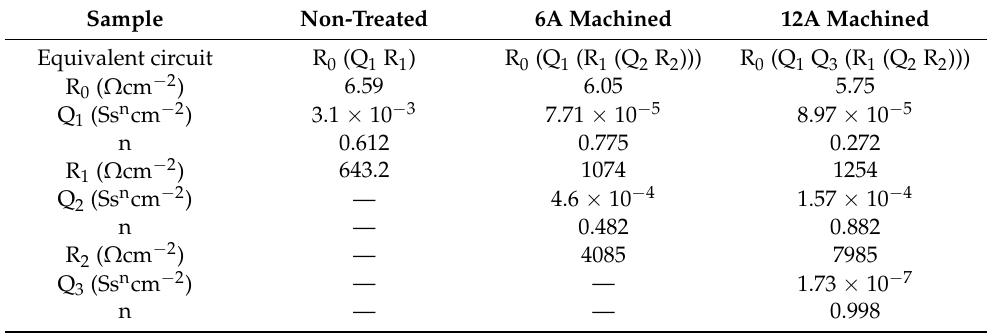
Table 4. Values of the equivalent circuit elements to fit EIS for the EDA machined surface with different peak current along with the non-treated